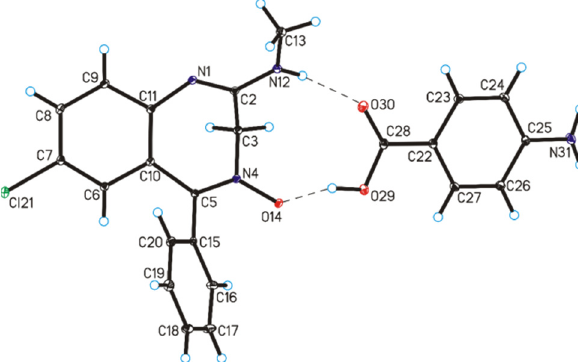
Figure 5. Molecular structure of chlordiazepoxide co-crystals with p -aminobenzoic acid, showing the atom-labeling scheme (displacement ellipsoids are drawn at a 25% probability level and H atoms are shown as small spheres of arbitrary radius; hydrogen bonds are represented by dashed lines).